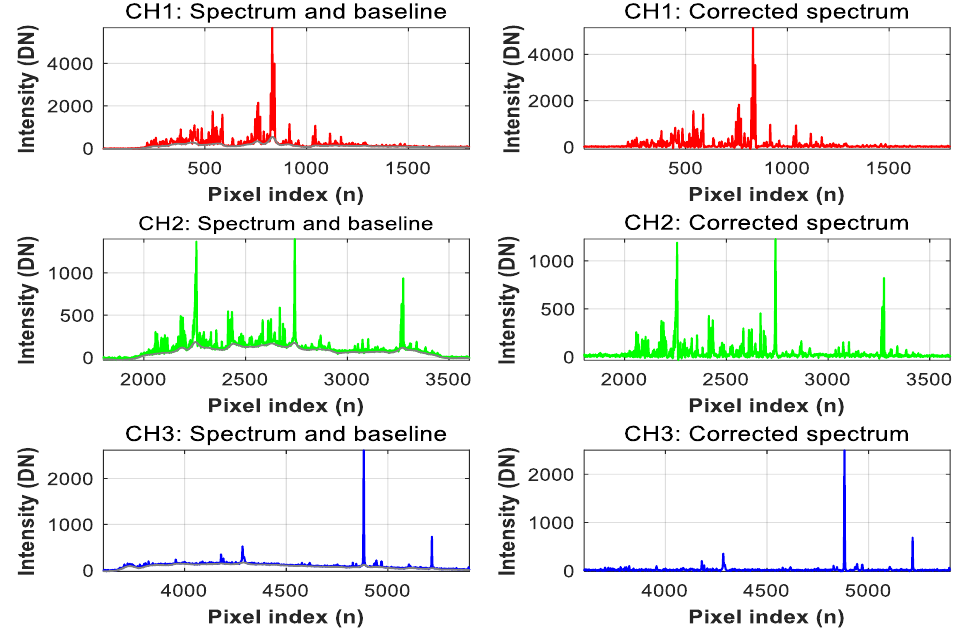
Figure 4. Correcting baseline of one spectrum within three channels for Sample-A06.